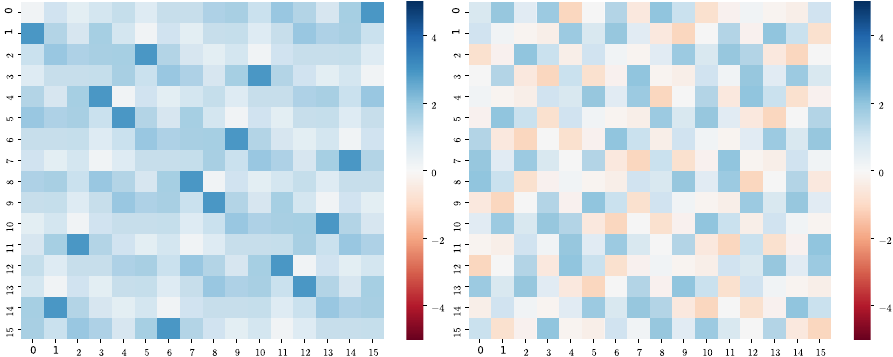
Figure 17: Theoretical index-dependent means from the equation system for our four-round distinguisher with the S-box of Small- AES and that of PRESENT, in multiples of | µ deviations from the mean of the PRP. Each cell represents the mean of the result for the active input cell in the plaintexts ( y -axis) and the tested inactive cell ( x -axis) after four rounds without the final MixColumns operation. Darker color (ignorant of sign) imply better